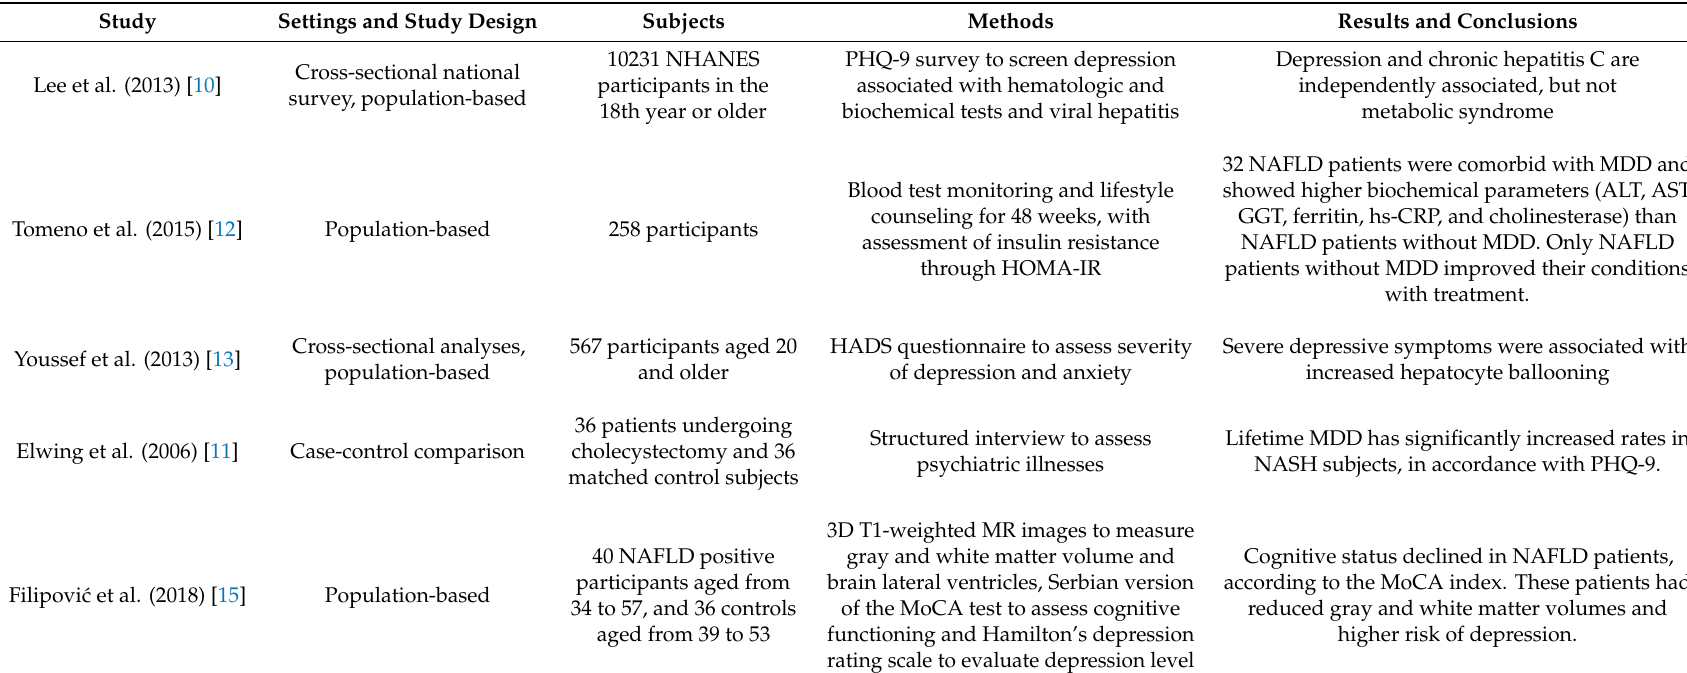
Table 1. Principal clinical studies reporting an association between depressive disorders and